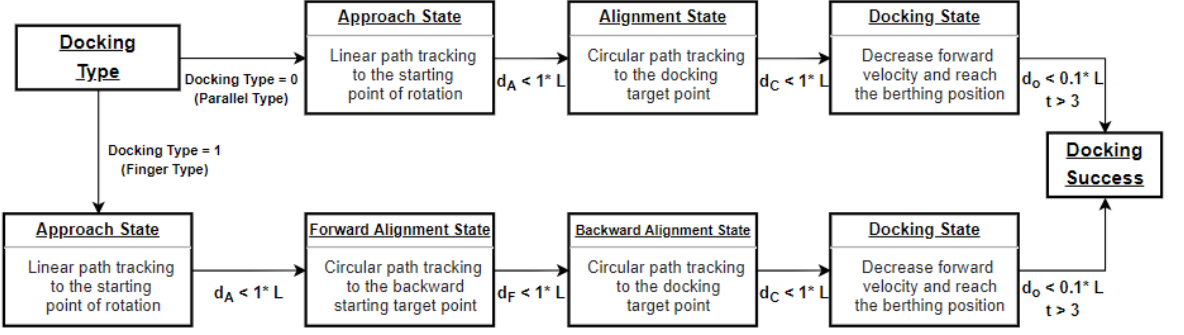
Figure 3. State machine that expresses the parallel/finger-type berthing process as a state